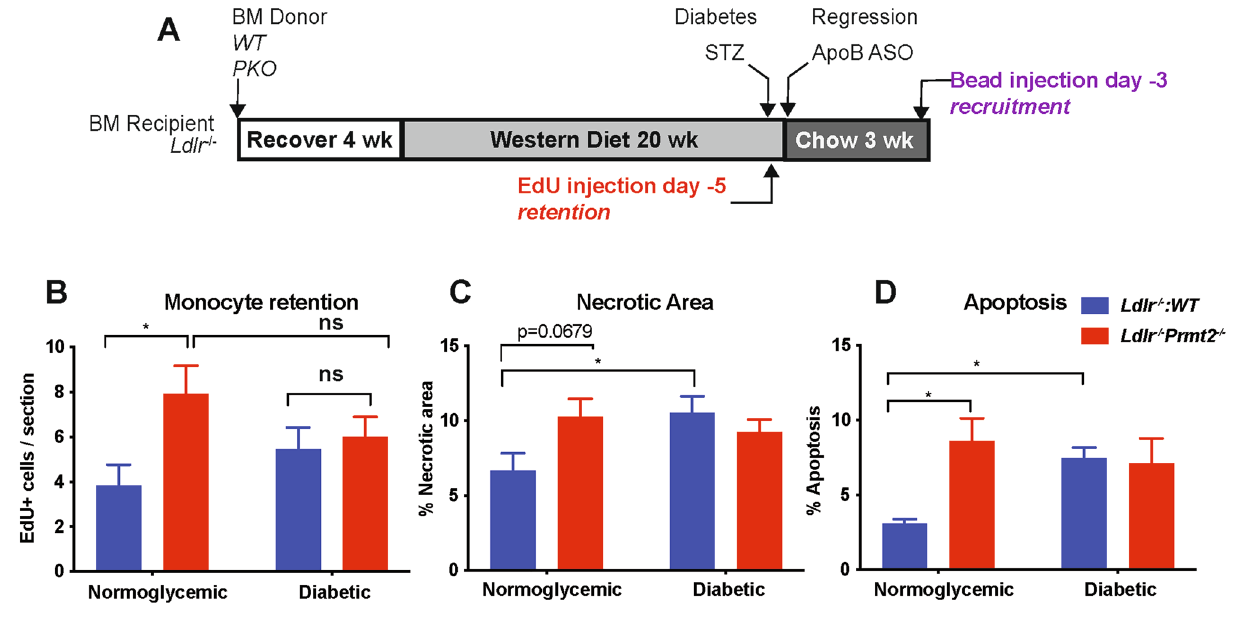
Figure 2. Macrophage dynamics show that monocyte retention is the key kinetic change impairing regression in Ldlr −/− :Prmt2 −/− mice in normoglycemia. ( A ) Schematic of timeline for EdU and bead injections to assess retention and recruitment of monocytes, respectively, into aortic roots under regression conditions. ( B ) Analysis of EdU: CD68+ cells/section of atherosclerotic plaques from the indicated groups showing significantly increased recruitment of EdU+ cells into Ldlr −/− :Prmt2 −/− compared to Ldlr −/− :WT under normoglycemic conditions. Plaques were also stained for CD68 and the number of EdU+/CD68+ cells was measured. ( C ) Quantification of necrotic area and ( D ) cleaved caspase 3 (to assess apoptosis) in plaque sections showing increased necrosis and apoptosis in Ldlr −/− :Prmt2 −/− vs Ldlr −/− :WT under normoglycemic conditions. Data (means ± SEM) were analyzed using one-way ANOVA followed by Bonferroni’s multiple comparison test. * P <